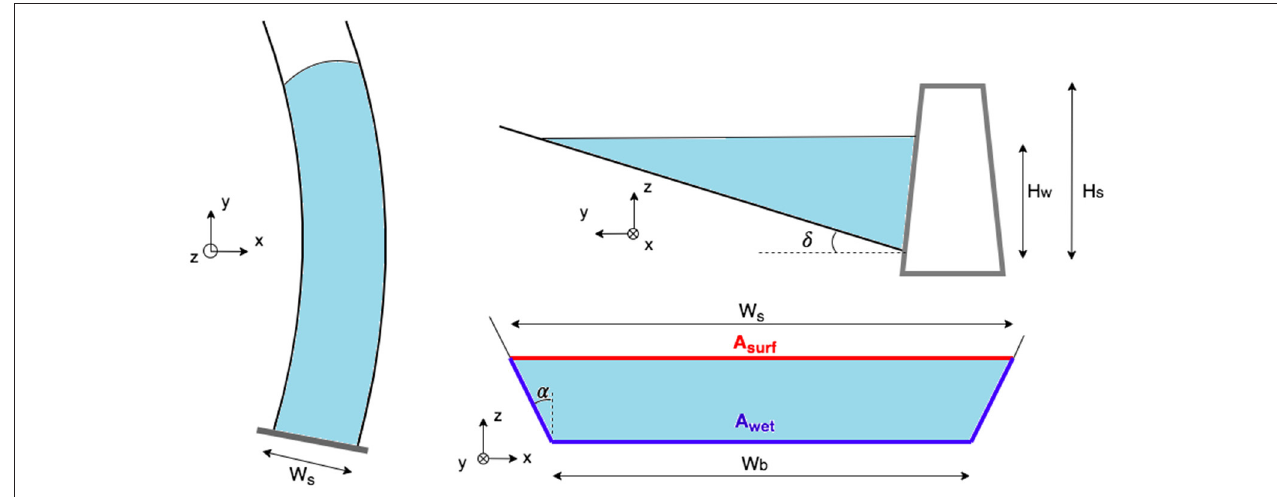
FIGURE 2 | Cross-sections of a check dam and stored water